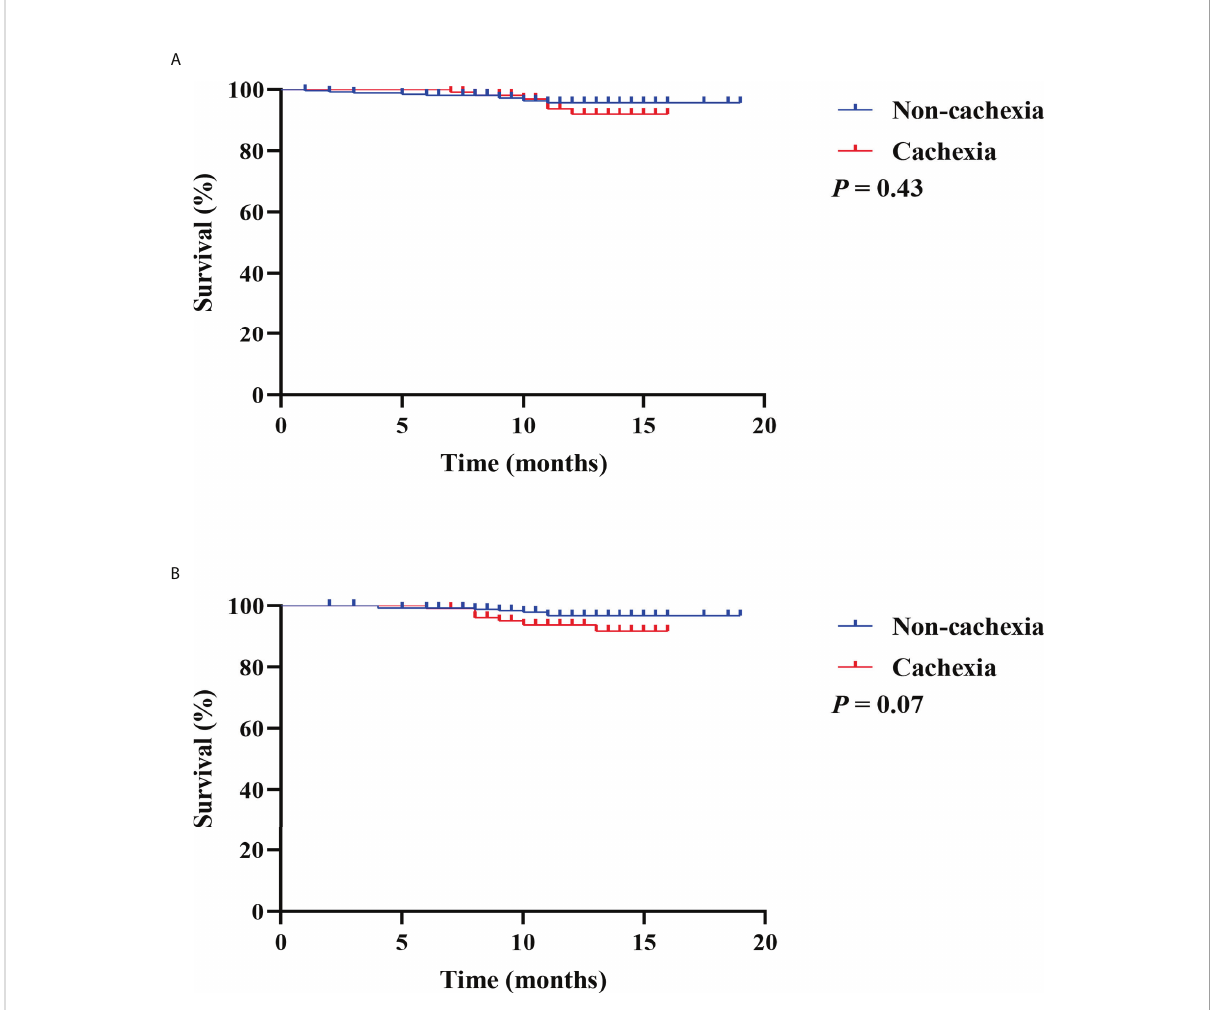
FIGURE 4 Kaplan Meier survival curves for the associations between cachexia and (A) overall survival; (B) recurrence free